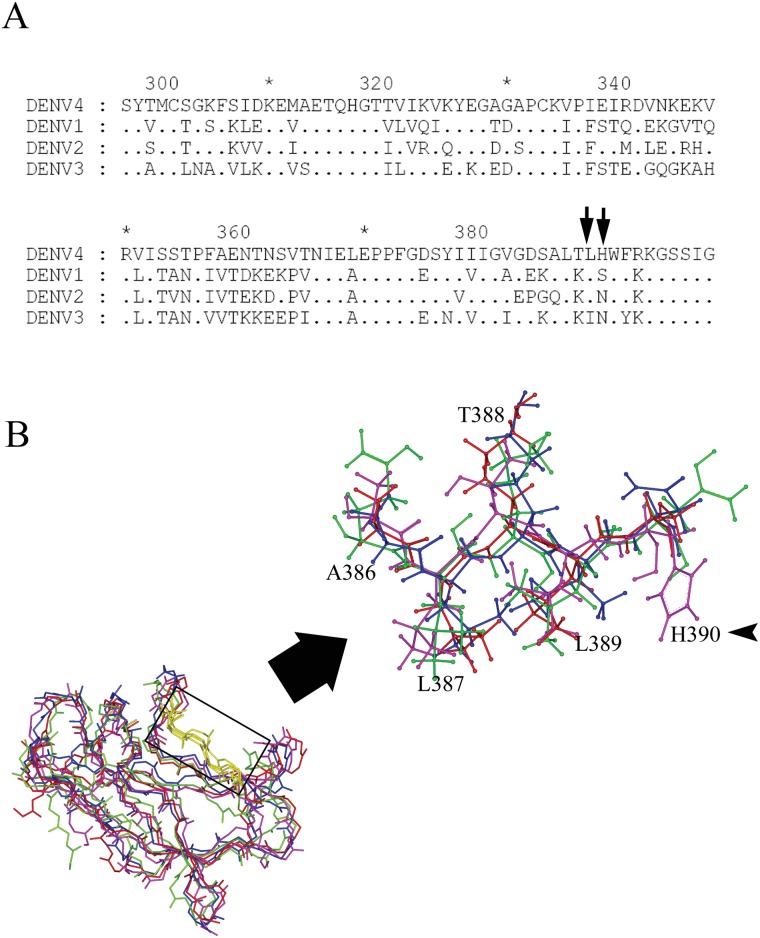
Amino acid sequence alignment of domain III from DENV1-4 and location of the mAb 1G6 epitope.
(A) Comparison of amino acid sequences of ED3 proteins of wild-type DENV4 and other DENV serotypes. Identical amino acids were indicated by dots, and the unique residues were marker by arrows. (B) Overlay of crystal structures of DENV1-4 ED3. The localization of amino acid substitutions at positions 387–390 in the 3-D structure of monomeric DENV4 ED3, is shown from the side.